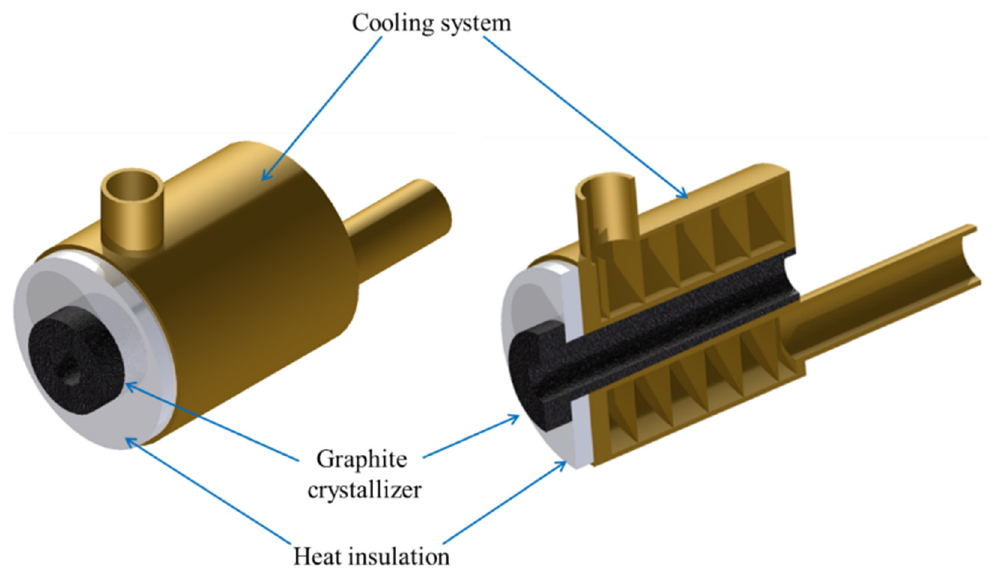
Figure 1. Schematics of the melting and casting furnace.